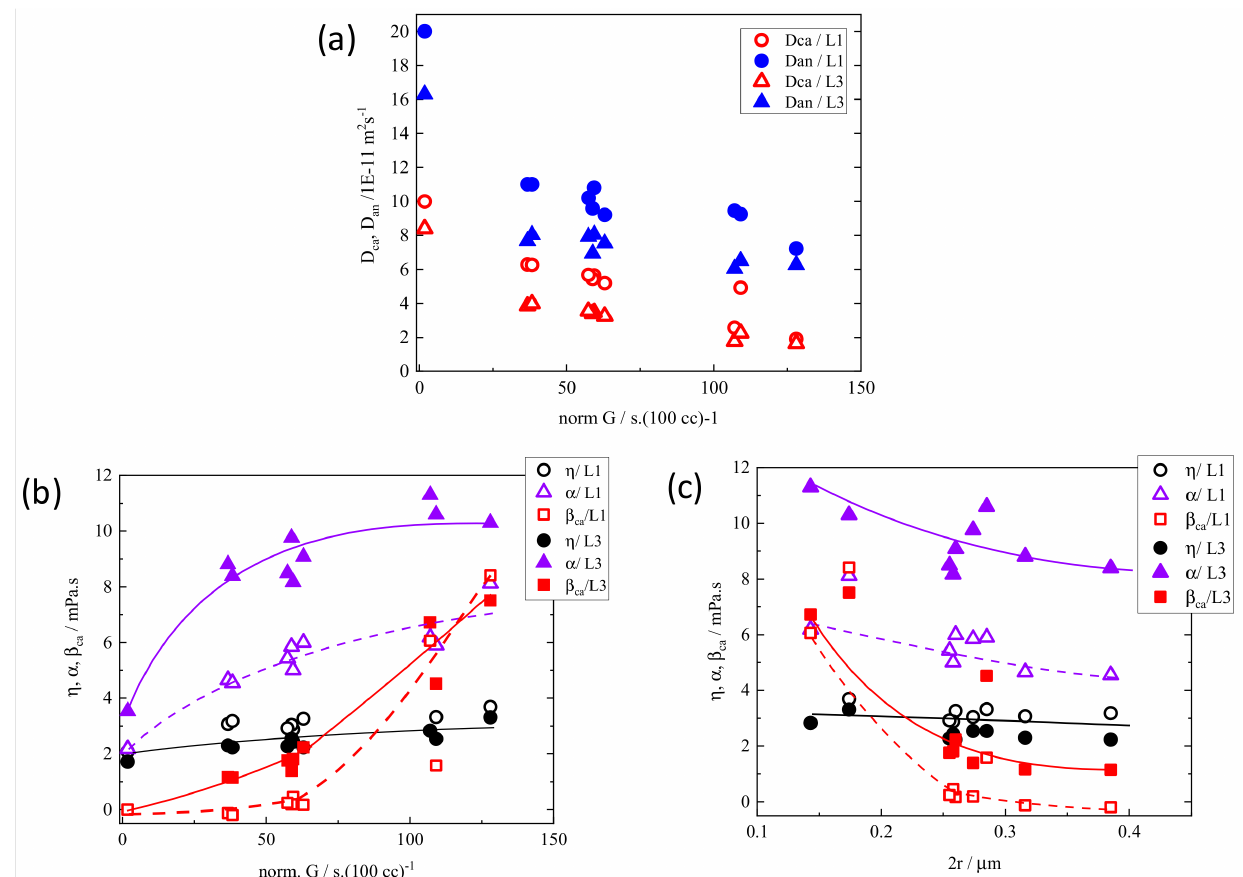
Figure 7. ( a ) D ca and D an with respect to normalized G (= G (cid:48) ), and microviscosities, η , α , β ca of the ionic species with respect to ( b ) normalized G (= G (cid:48) ) and ( c ) average pore diameter of L1 and L3 solutions in the PP separator membranes. Reprinted with permission from [33]. Copyright 2018 ACS